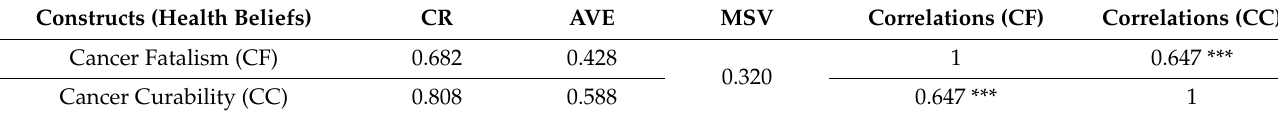
Table 3. Constructs reliability and